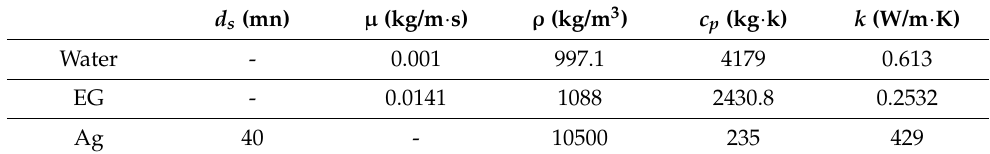
Table 2. Organic nanoparticle properties